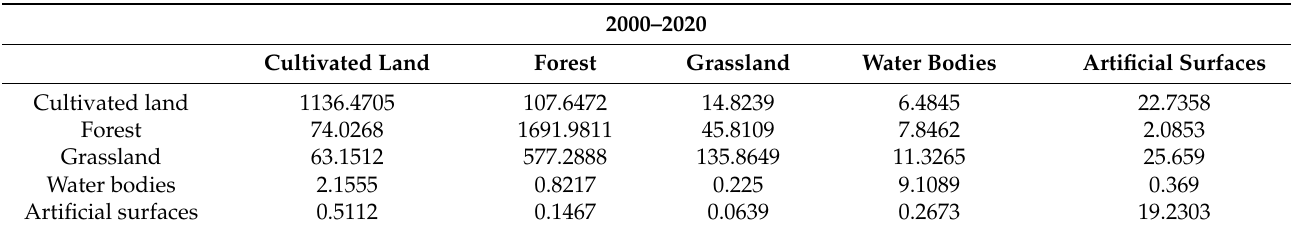
Table 3. Transition matrix of land-use types in Enshi City from 2000 to 2020 (km 2 ).